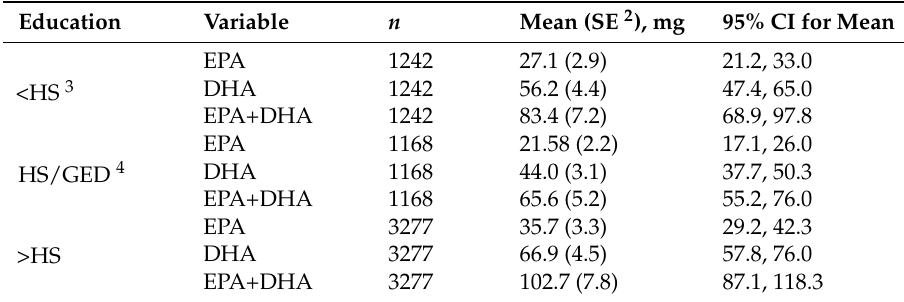
Table 4. Omega-3 fatty acid intake and educational attainment 1 .